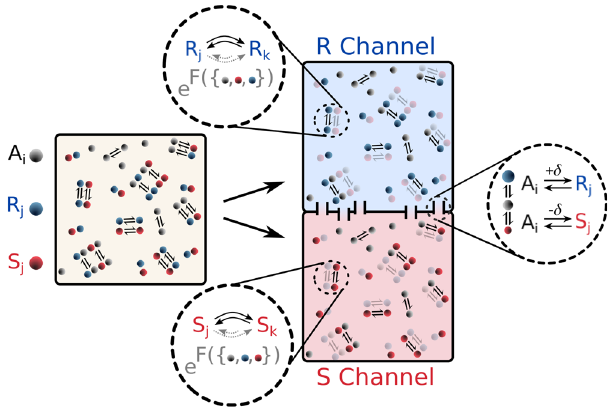
Fig. 1 Chemical model. Reaction schematic in a solution of achiral elements A i (gray) and chiral elements R j ( S j ), where R j (blue) is the chiral counterpart of S j (red). Under total enantioselectivity, the system (yellow box on left) can be decomposed into quasi-independent but mirrored R (red) and S (blue) con fi guration channels. Dashed insets show a sample equilibrium chiral reaction between elements R j ( S j ) and R k ( S k ). A fraction of these reactions is randomly doubled and driven by environmental forces F γ which depend on a complex expression of system elements { A i , R j , S k }. Force expressions are identical but mirrored (i.e., R j → S j and vice-versa) to maintain channel symmetry. The two channels are connected by “ canals ” (rectangular passages) which allow mass exchange between channels via achiral-to-chiral reactions. This exchange is symmetric but may vary by a random fraction δ as a result of environmental fl